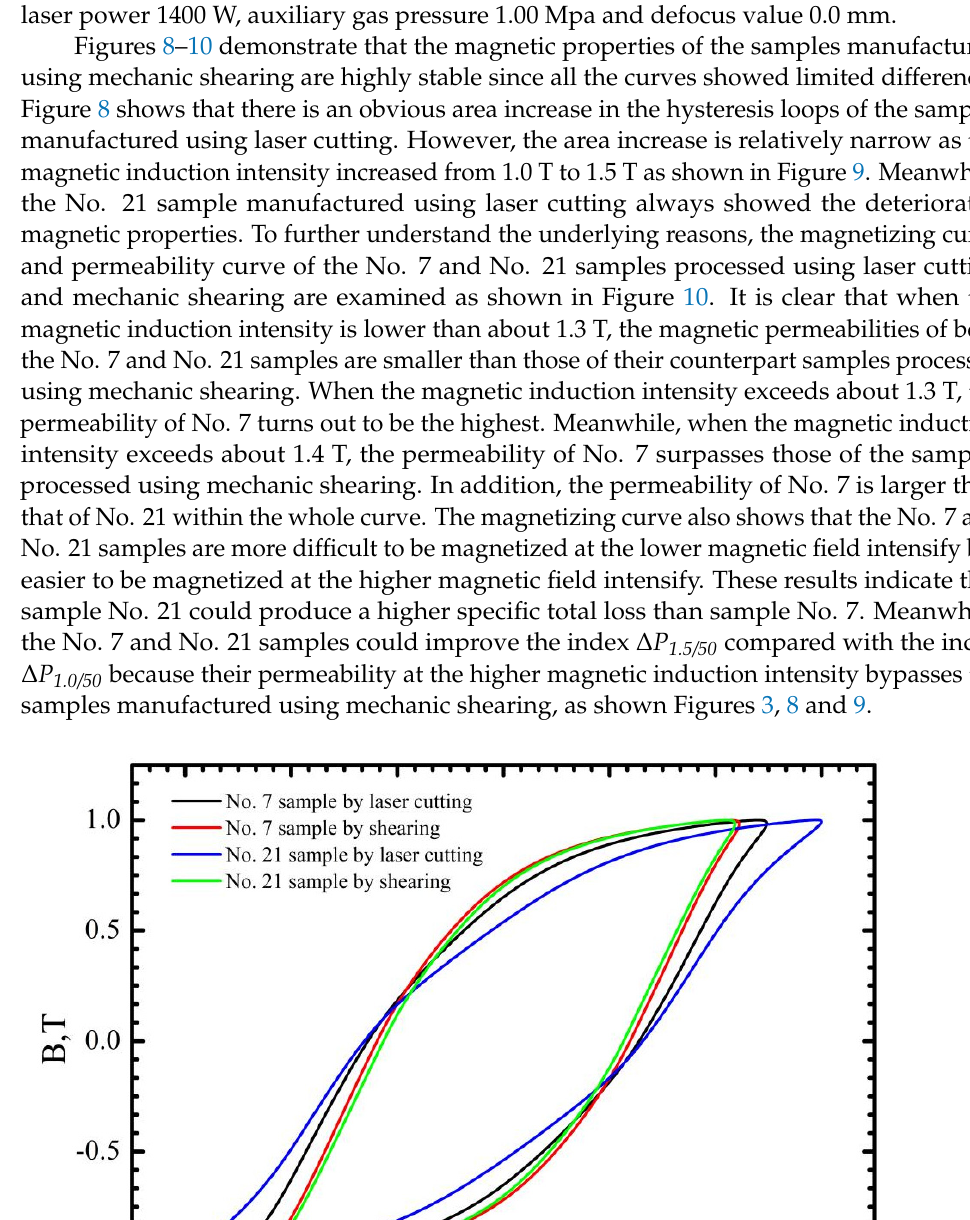
Figure 9. Hysteresis curves at the magnetic induction intensity of 1.5 T of the No. 7 and No. 21 samples processed using laser cutting and mechanic shearing, respectively.